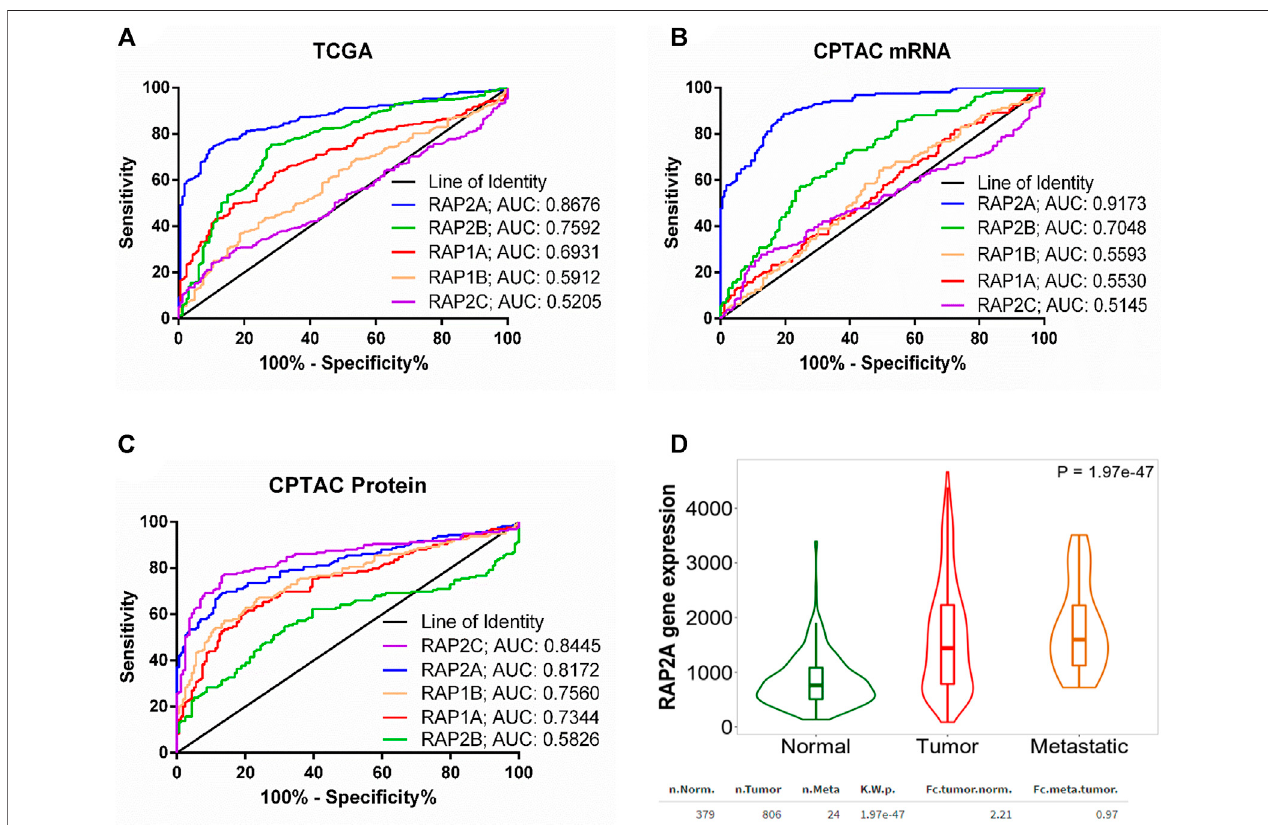
FIGURE 2 | (A) ROC curve for the utility of RAP gene expression to differentiate between liver tumor tissues and normal tissue group in (A) TCGA mRNA data (B) CPTAC mRNA data, and (C) CPTAC protein expression data. For (A) , normal tissue group consisted of tumor-adjacent normal tissues from TCGA study and normal tissues from non-disease controls from the GTEx study. (D) Comparison of RAP2A gene expression among normal tissue, tumor tissue, and metastatic tissues assessed through TNM